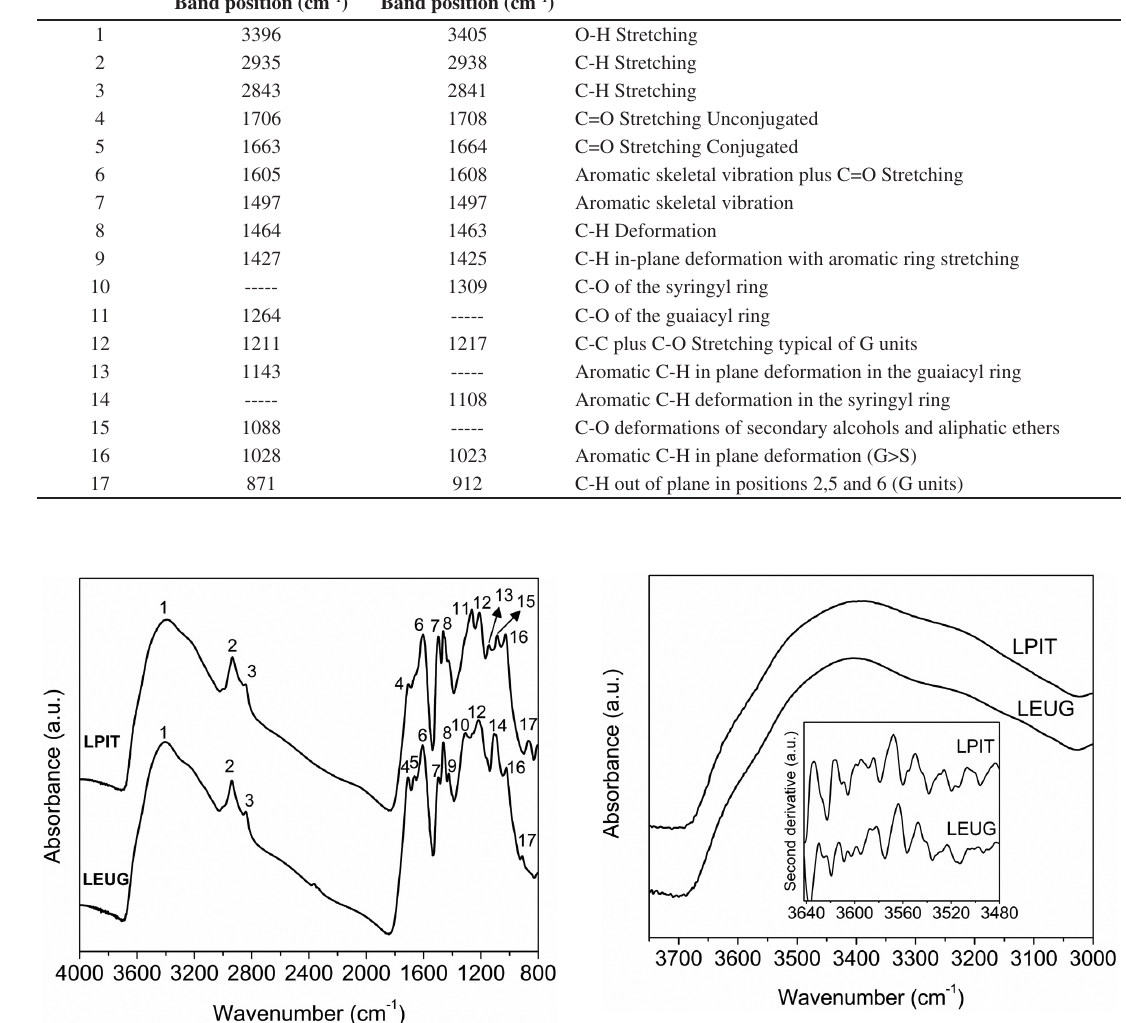
Figure 5. FTIR spectra in 3700-3000 cm –1 and second derivative FTIR spectra for both